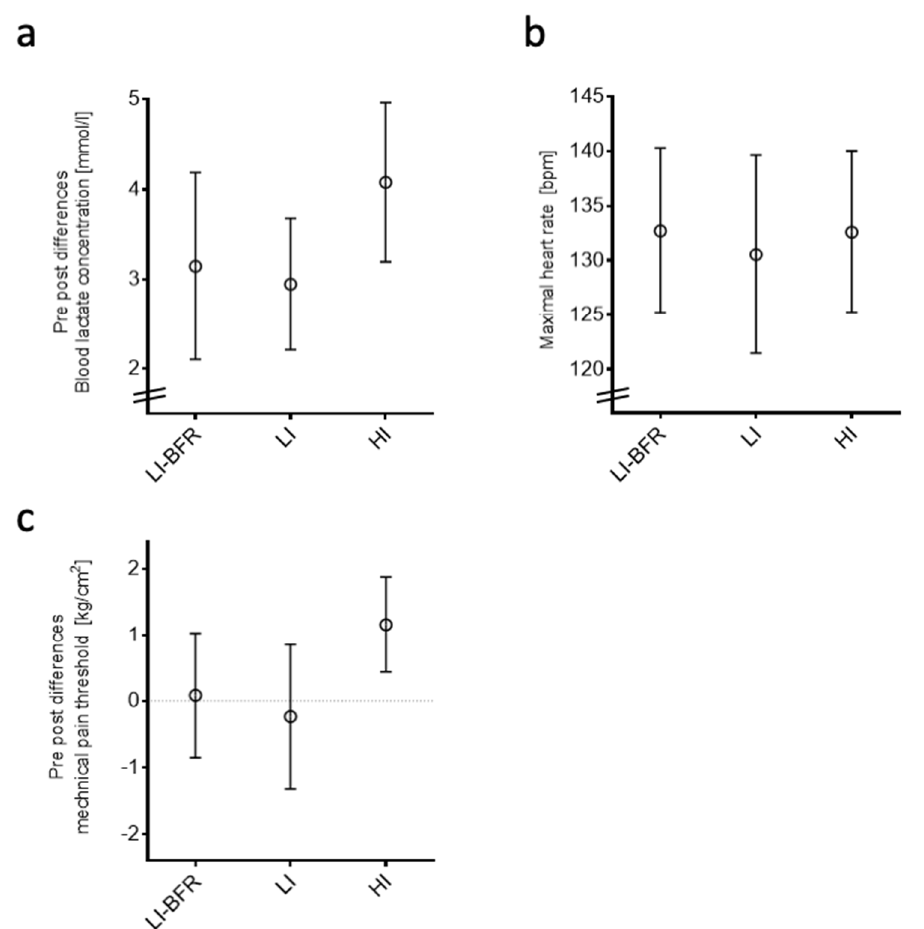
Figure 2. Objective outcomes of training interventions. Data are displayed as mean and 95% confidence intervals. Bpm, beats per minute; LI-BFR, low-intensity training with blood flow restriction; LI, low-intensity training; HI, high-intensity training. ( a ) Differences in blood lactate concentration pre- and post-training, ( b ) maximal heart rate, and ( c ) differences in mechanical pain threshold pre- and post-training.